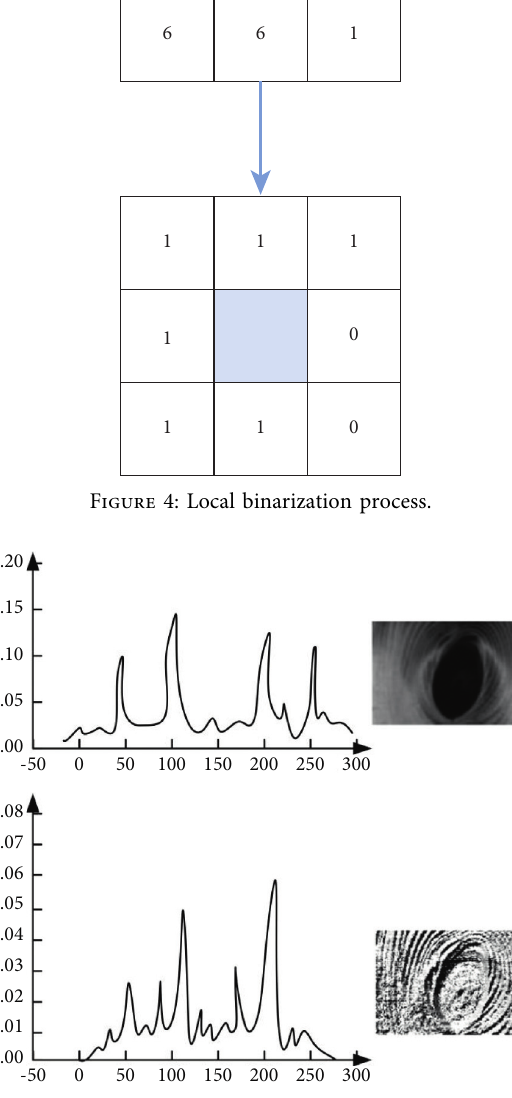
Figure 5: The histogram of the image processed by the grayscale and multimedia resource topic search